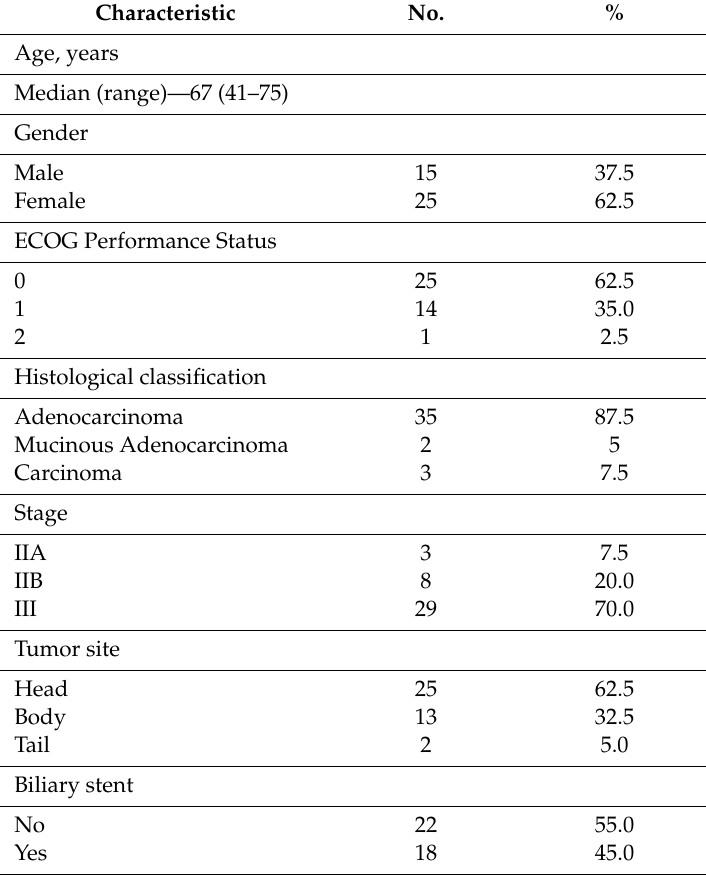
Table 1. Patient characteristics at baseline (No. =